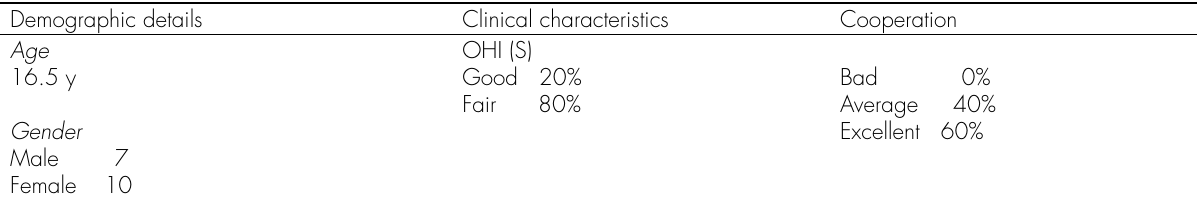
Table I. Baseline characteristics of patients.